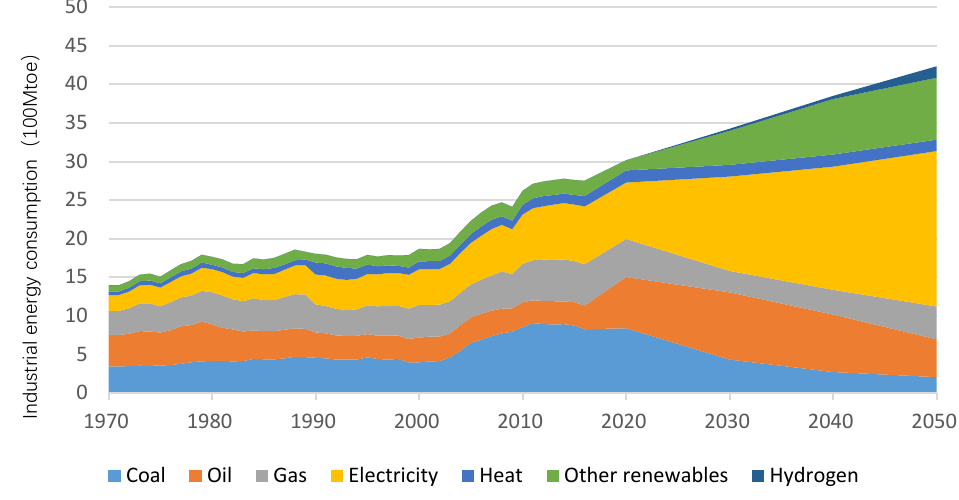
Figure 13. Energy Consumption and Structure in Industry Sector Based on MESSAGE Optimization Analysis.